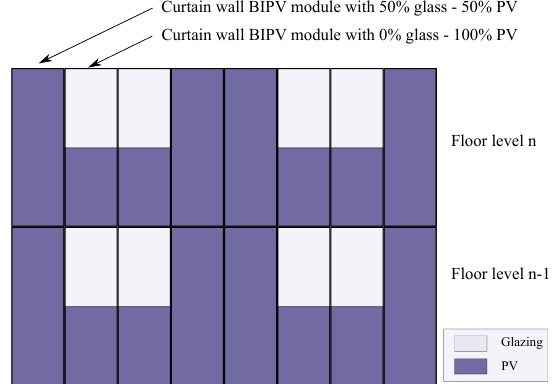
Figure 2. The zoom on a small part of a typical apartment or office building façade where building-integrated photovoltaic (BIPV) curtain wall modules can be used. To illustrate the modularity principle, the size of the curtain wall element remains the same but the ratio glass/photovoltaics (PV) can be